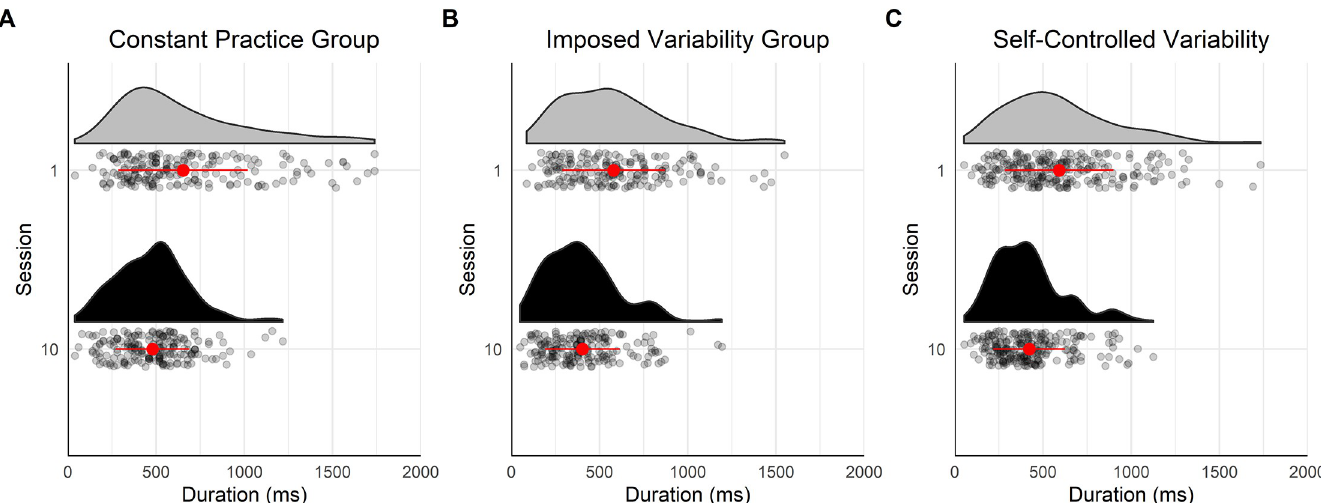
Fig 5. Duration of the last gaze visit before the hand contacted the handhold for the three groups on the training route. In (A), (B) and (C), each point represents one gaze visit before a contact with a handhold, the half violin shows the density of points, the red/grey point with the error bar refers to the mean of all the gaze visits and the standard deviation around the mean. The color of the half violin refers to the learning session: in grey, session 1 and in black, session 10. (A), (B) and (C) shows data for the constant practice group, imposed variability group and the self-controlled variability group respectively.